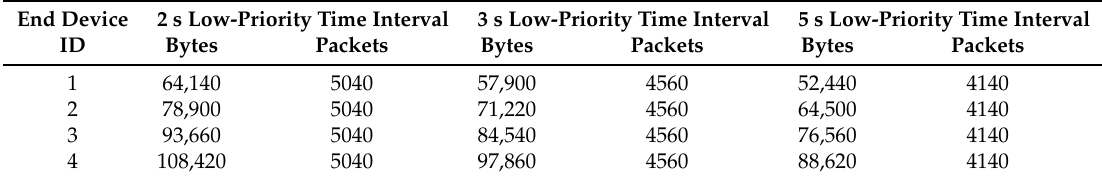
Table 2. Number of processed bytes in the EEMIP mode without retransmissions.